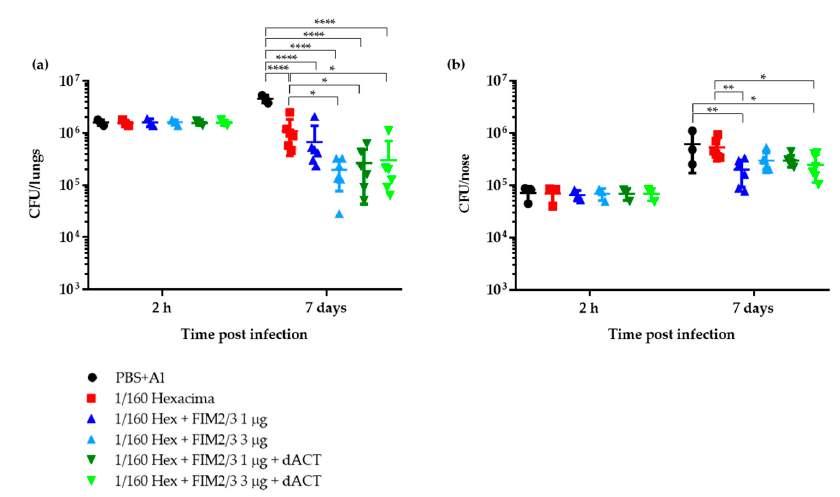
Figure 1. Protection against intranasal B. pertussis challenge in BALB/c mice immunized by 1/160 human dose (HD) of antigen-supplemented Hexacima ® aP vaccine. Mice were immunized intraperitoneally on days 0 and 14 with 1/160 HD of the aP vaccines (1/160 HD Hexacima ® , 1/160 HD Hexacima ® + FIM2/3 (1 µg), 1/160 HD Hexacima ® + FIM2/3 (3 µg), 1/160 HD Hexacima ® + FIM2/3 (1 µg) + dACT (30 µg) and 1/160 HD Hexacima ® + FIM2/3 (3 µg) + dACT (30 µg)). Mice injected with phosphate-buffered saline (PBS) + alum (0.208% w/v ) served as negative controls. Mice were challenged intranasally with B. pertussis BPSM (1.4 × 10 6 CFU in 2 × 10 µL) on day 35. Mice were sampled at day 0 + 2 h and day 7 post challenge for enumeration of bacteria in the lungs ( a ) and in the nasal cavity ( b ). Results represent the bacterial counts for three to six mice per group ± SD. Two-way ANOVA followed by Tukey’s multiple comparison test was used to analyze the statistical significance between groups. Only significant di ff erences are indicated. * ( p < 0.05); ** ( p < 0.01); **** ( p <